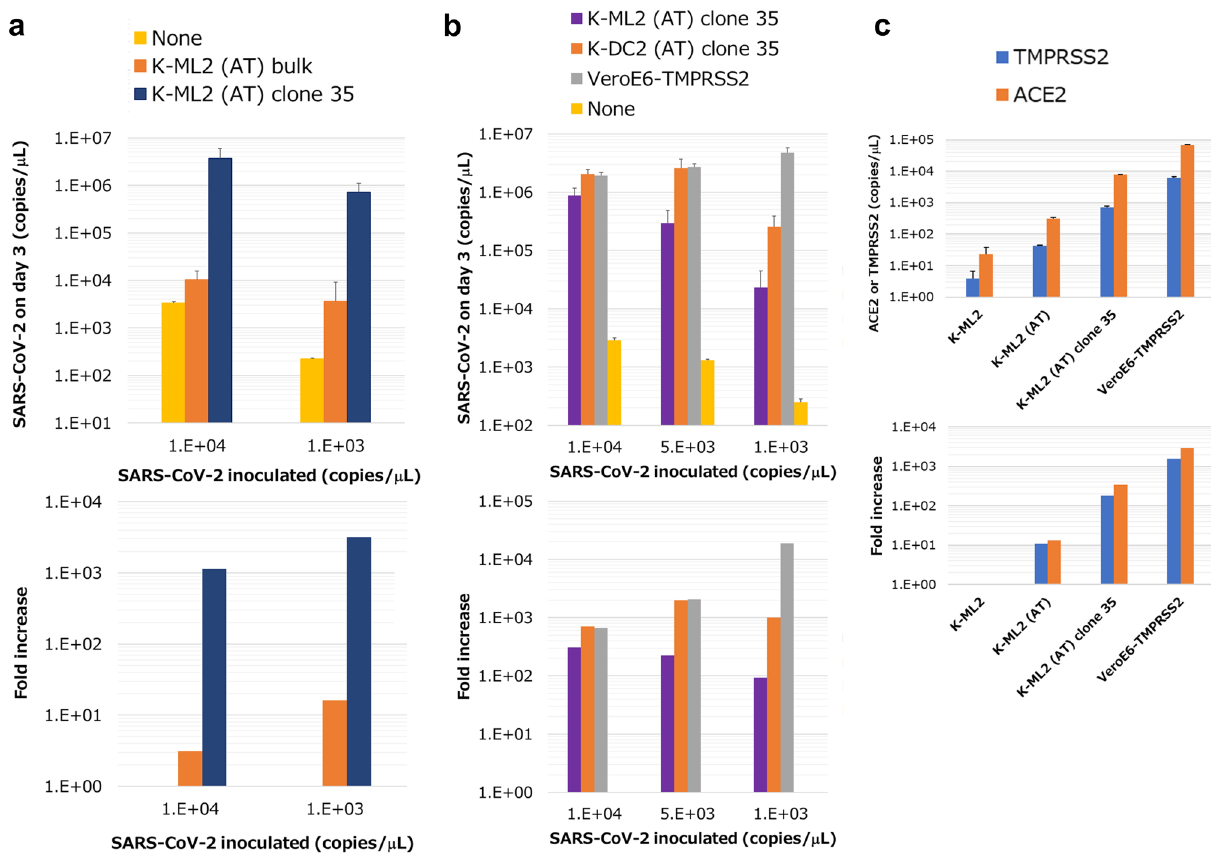
Figure 2. Comparison of K-ML2 (AT) bulk and K-ML2 (AT) clone 35. ( a ) K-ML2 (AT) bulk and clone 35 cells or ( b ) clone 35 cells before and after DC-differentiation were cultured with SARS-CoV-2 and evaluated as in Fig. 1. ( c ) The amount of ACE2 and TMPRSS2 in the indicated cells was measured by qPCR (top). The fold increase compared with K-ML2 is shown in the bottom panel. Error bars indicate SD. N =